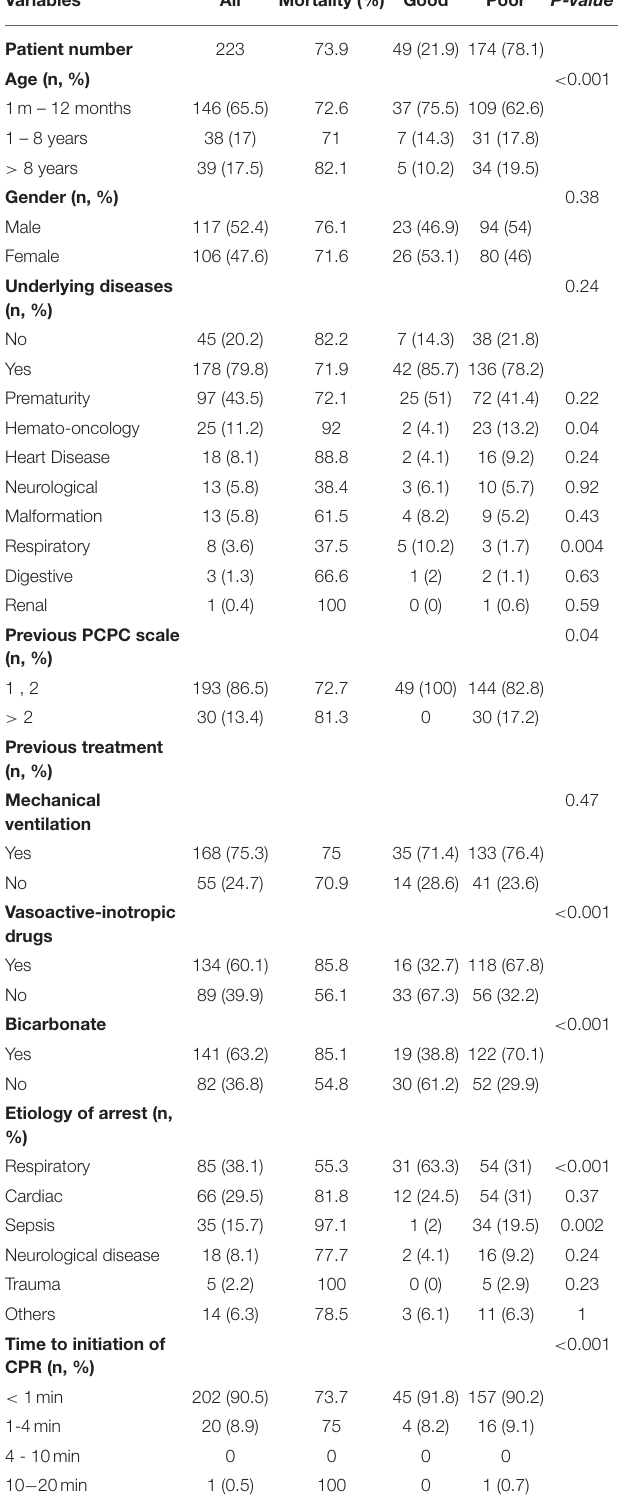
TABLE 1 | Clinical characteristics and risk factors associated with prognosis of in-PICU CA. Variables